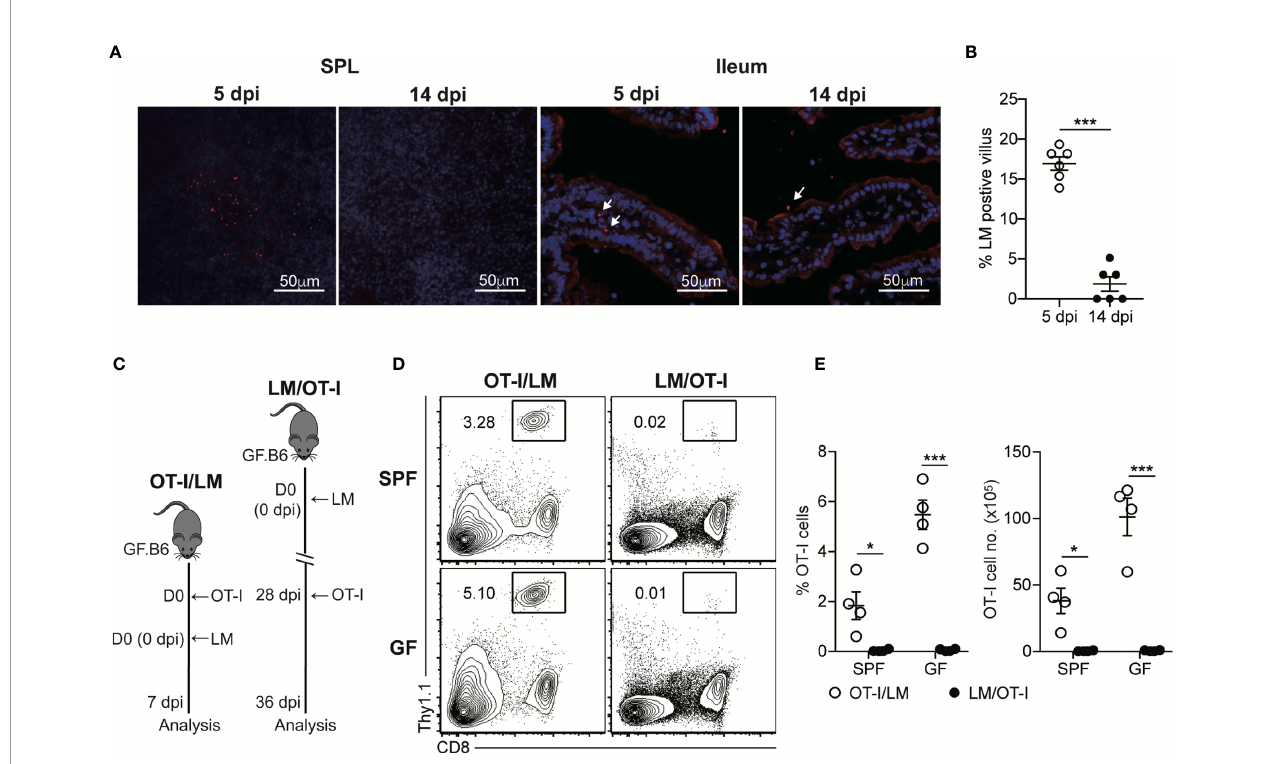
FIGURE 3 | Luminal L. monocytogenes Fails to In fi ltrate Through the Intestinal Epithelium at the Late Phase of Infection in GF mice. (A) GF mice were orally infected with InlA m LM-OVA . SPL and ileum tissues were prepared at 5 and 14 dpi, and stained for L. monocytogenes (red) and nucleus (blue). Arrows indicate the foci of L. monocytogenes in siLP or lumen. (B) Percentage of villus containing L. monocytogenes in ileum at 5 and 14 dpi (n=6 per group). (C-E) 5 x 10 5 OT-I cells were adoptively transferred into naïve SPF and GF mice and infected with InlA m LM-OVA next day (OT-I/LM). 5 x 10 5 OT-I cells were adoptively transferred into SPF and GF mice previously orally-infected with InlA m LM-OVA at 28dpi (LM/OT-I). (C) Scheme of the experiment. (D) Representative FACS plots showing the percentage of OT-I cells gated on lymphocytes in SPL at day 8 after adoptive transfer. (E) Percentage of OT-I cells gated on live lymphocytes (left) and total numbers (right) of OT-I cells in SPL from indicated mice. Data are representative of two independent experiments (n=3~4 per group). Statistical differences were determined by unpaired two-tailed Student ’ s t test or two-way ANOVA with Tukey ’ s multiple comparisons. *P < 0.05, ***P <